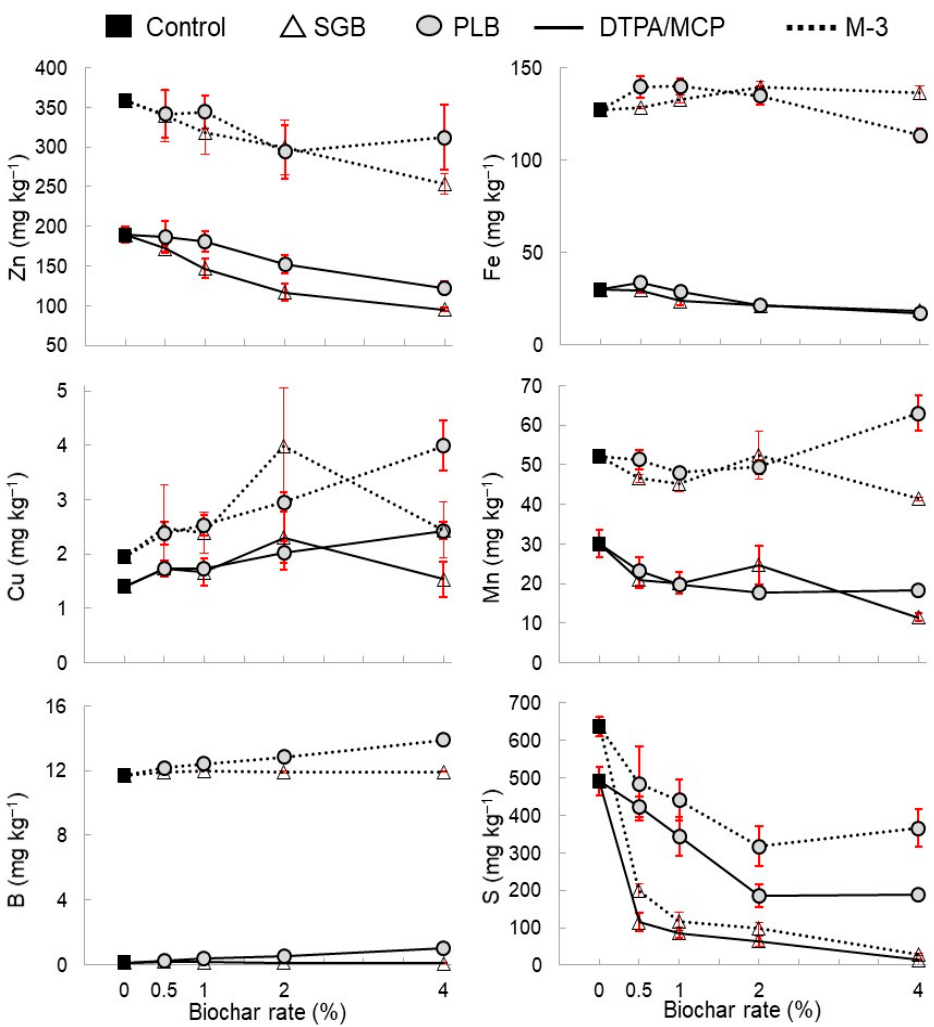
Figure 2. Effect of biochars on traditional (DTPA and MCP) and Mehlich-3-extractable nutrients at rates of 0, 0.5, 1, 2, and 4% after ~74 d of ryegrass cultivation. Red bars show the standard deviation (±SD) of means ( n = 3). DTPA: Diethylenetriaminepentaacetic acid. MCP: Monocalcium phosphate (Ca(H ₂ PO ₄ ) ₂ ·H ₂ O). M-3: Mehlich-3.